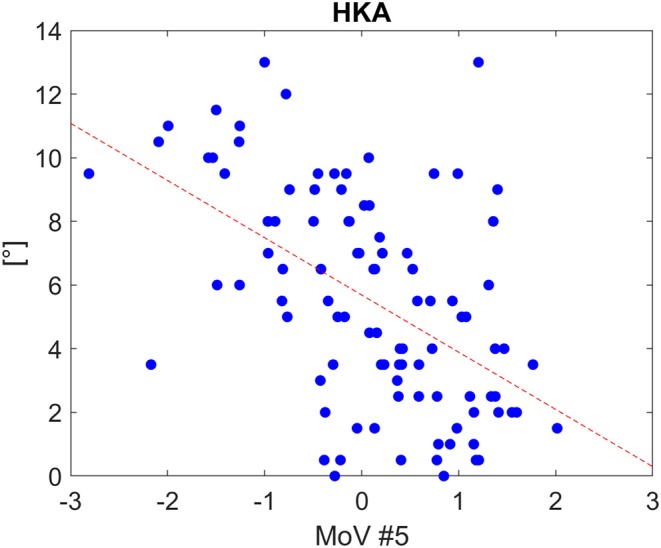
Scatter plot for HKA distribution as a function of MoV #5 range, along with the linear fitting (Spearman correlation coefficients: −0.52 with p<1e-07). The tendency line is depicted (red dashed line).